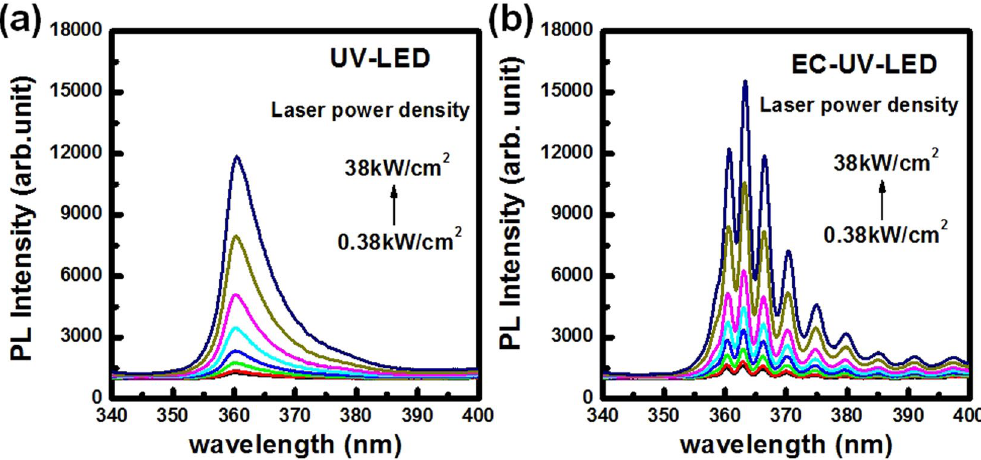
Figure 2. Power-dependent μ -PL spectra of the ( a ) UV-LED and ( b ) EC-UV-LED were measured at room temperature by varying the laser excited power density of the 325 nm HeCd laser.